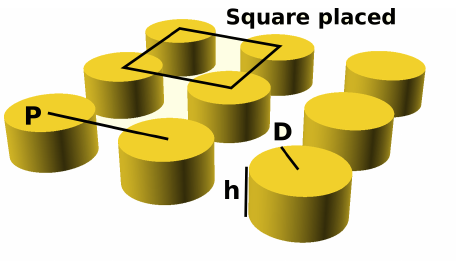
Figure 2. Example of a photonic crystal (PhC) slab with square-placed cylinders. The parameters defining such a geometry are the diameter of the cylinders D, the distance between the centers of consecutive cylinders P and the height of the structures